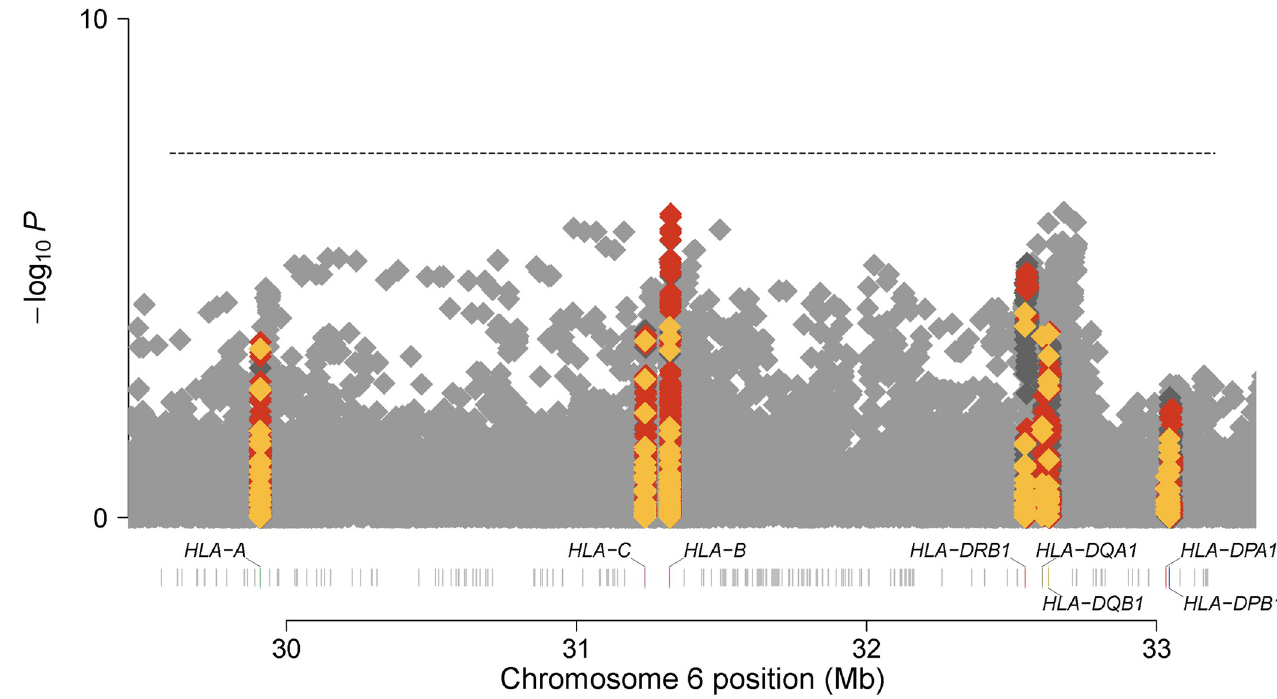
Fig 2. Manhattan plot for the marginal additive association between variation within the MHC and MS risk in the African American sample. Genomic position (HG19) is denoted on the x-axis and -log(10) P-value for the association of an additive effect of each SNP (grey), classical allele (yellow), and amino acid (orange) with MS risk on the